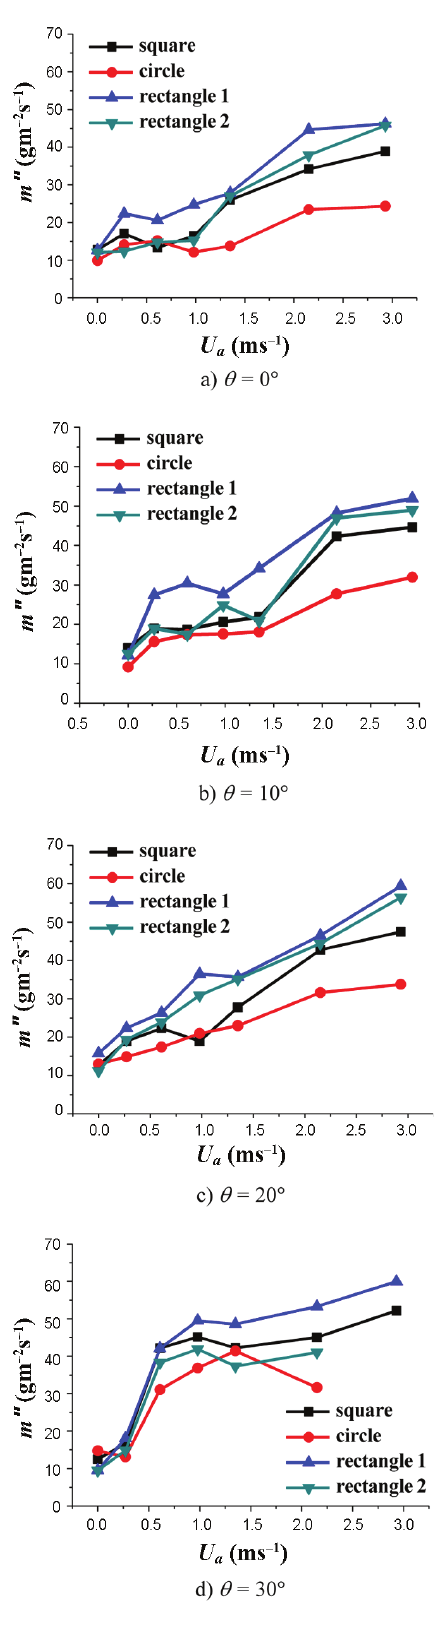
Fig. 5. Mass loss rate of different shape pools under different tunnel